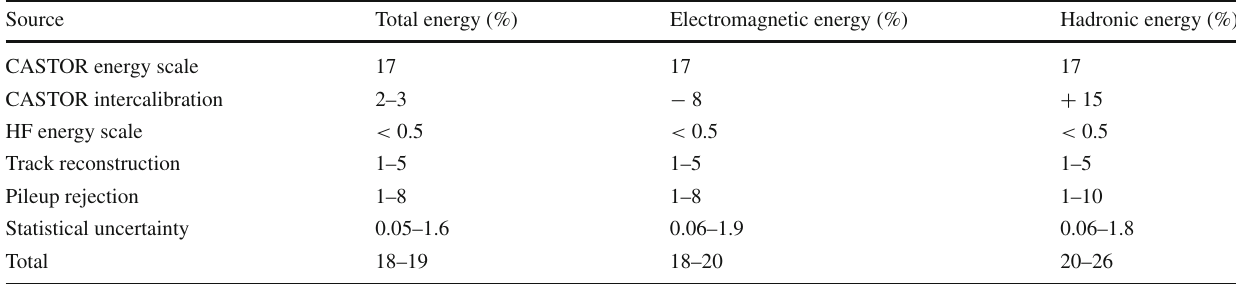
Table 1 Uncertainties in the average energies measured with the CASTOR calorimeter at the detector level. Ranges indicate the variation as a function of the track